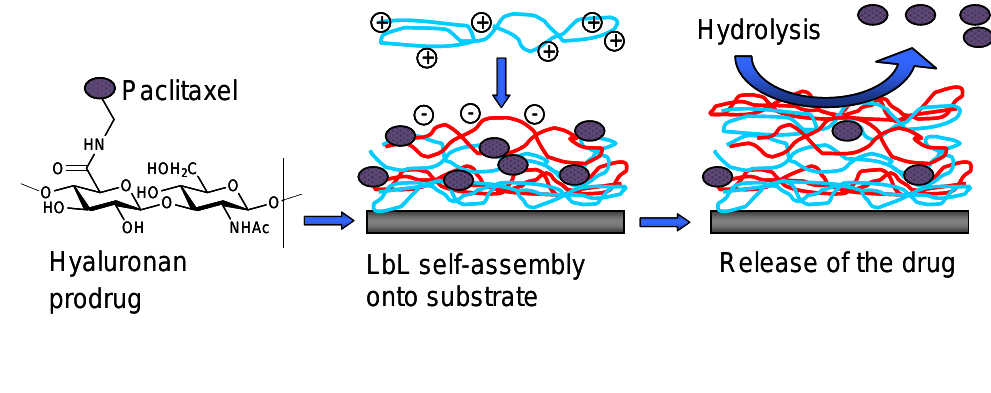
Figure 13. A schematic representation of the LBL process using paclitaxel-hyaluronic acid and chitosan